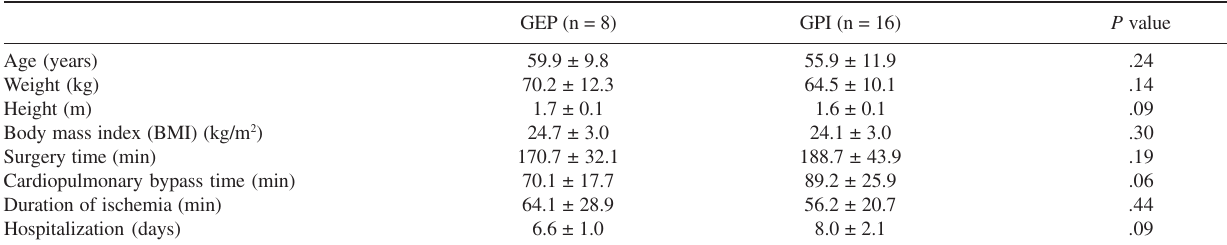
Table 1 - Anthropometrics, clinical, and surgical characteristics of the population studied (mean ±